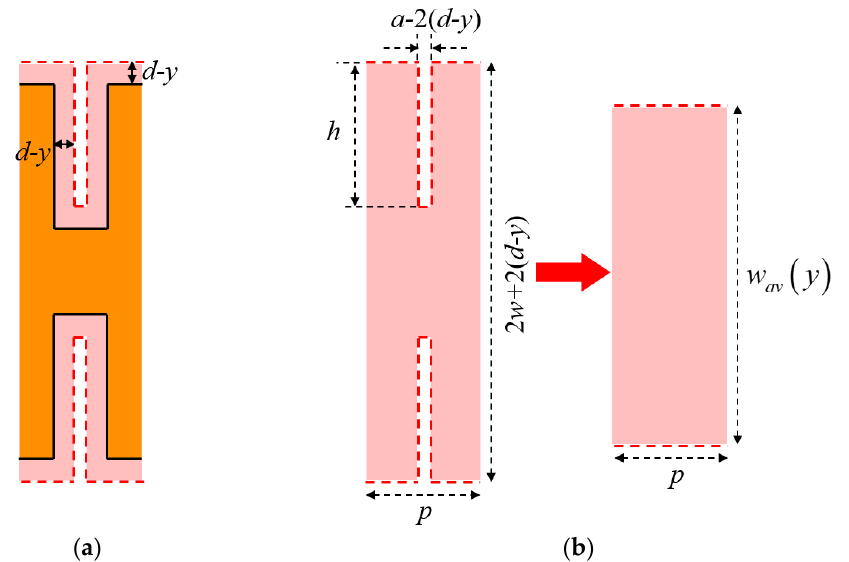
Figure 6. Top view of the heat flow region of H-shaped corrugated SWTL: ( a ) Boundary of the heat flow region; ( b ) schematic of w av ( y ).